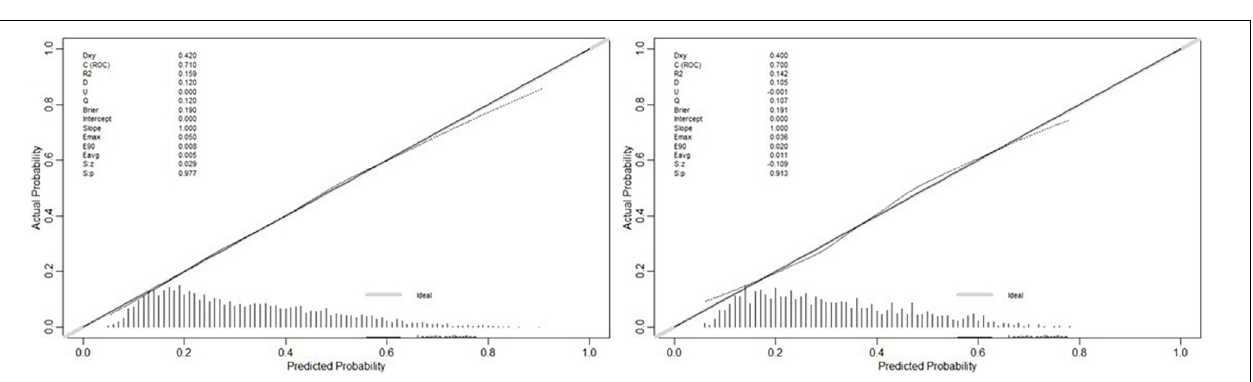
FIGURE 4 | The calibration curve of model for predicting exceeded NT-proBNP multiples in the training ( P = 0.977) and testing ( P = 0.913) dataset,